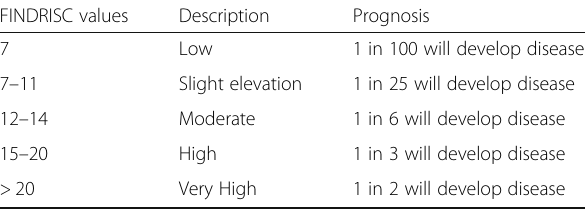
Table 1 Values of FINDRISC, description and prognosis FINDRISC